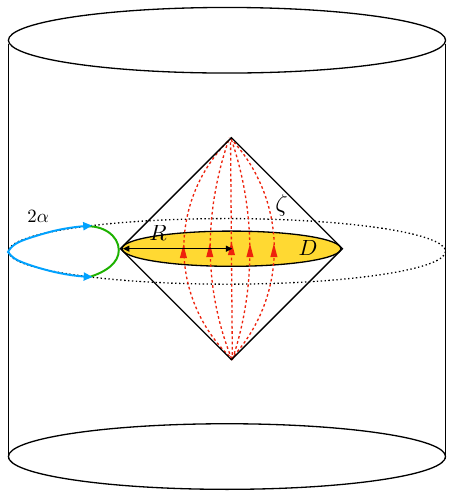
Figure 4 . A causal diamond in pure AdS 3 associated to a disk D (yellow region) of radius R . The bulk conformal Killing vector ζ generates a flow (in red) within the causal diamond, which sends the boundary of the diamond into itself, and leaves fixed the vertices and the circle ∂D . The minimal geodesic or Ryu-Takayanagi surface (in green), which is tangent to the circle, subtends an angle 2 α at the asymptotic boundary (in blue). Note that a larger boundary subregion corresponds to a smaller bulk disk and